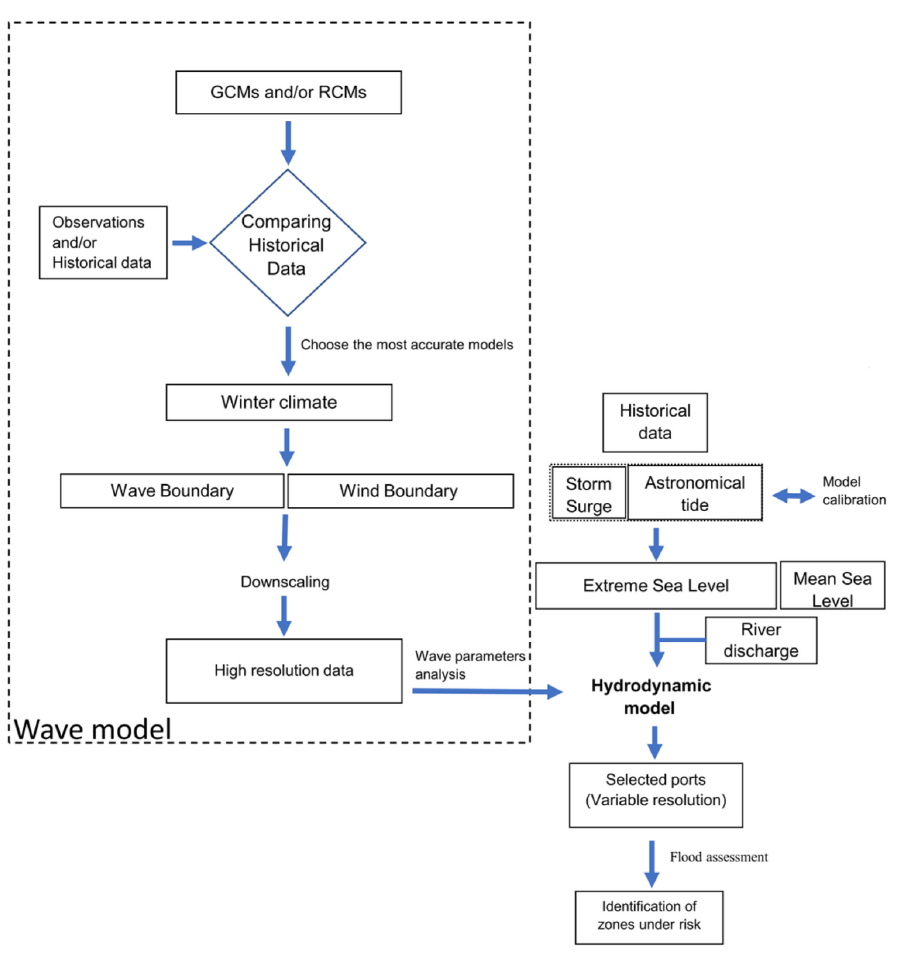
Figure 6. Methodological scheme of the procedure to assess the flood risk in ports under future conditions.